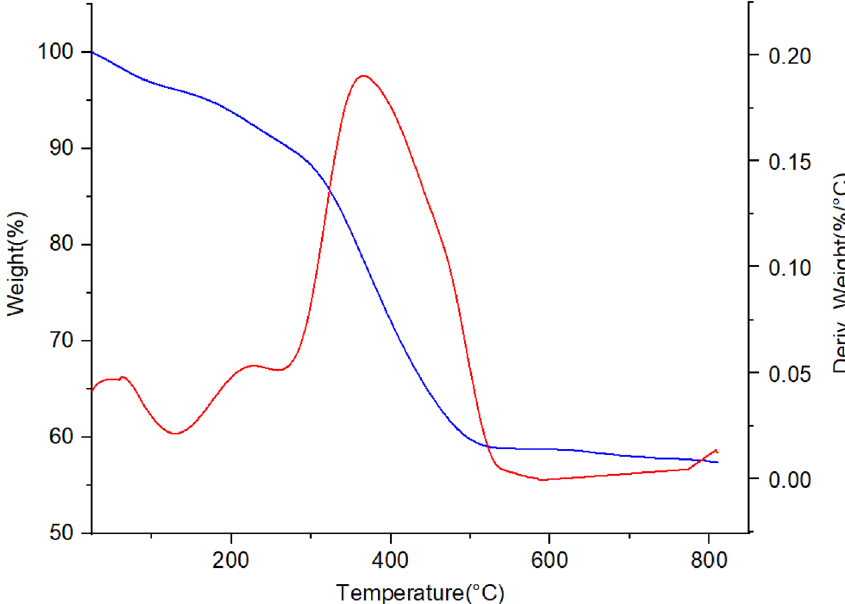
Figure 9. Thermal gravimetric (TG) and derivative thermal gravimetric (DTG) analysis of Fe 3 O 4 @MIL- 101(Cr)-N(CH 2 PO 3 ) 2 .